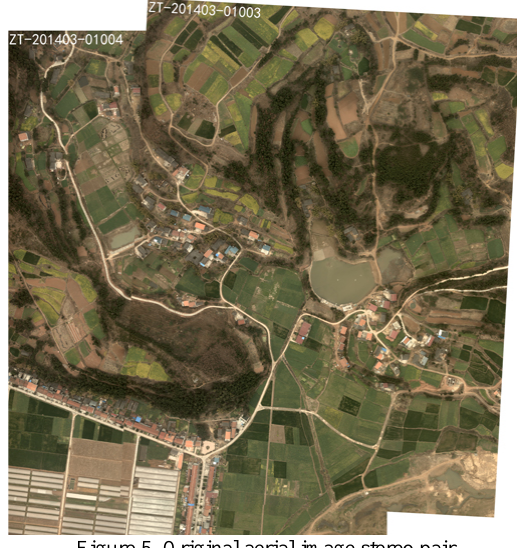
Figure 5. Original aerial image stereo pair